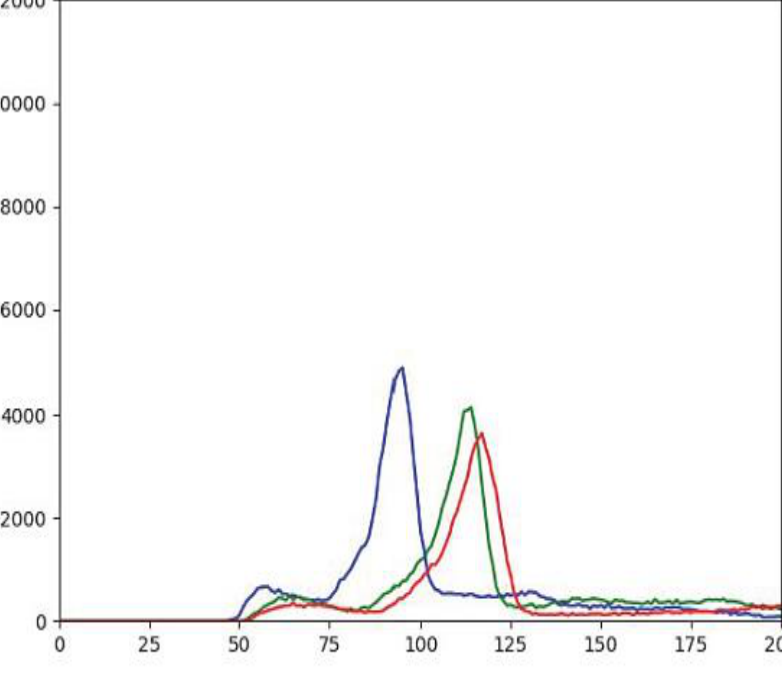
Figure 14. Histogram of the RGB graph for the image (see Figure